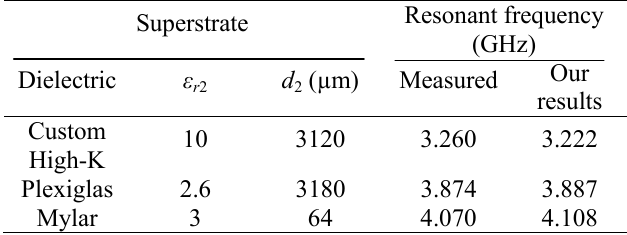
Table 1: Comparison of our calculated resonant frequencies with experimental data [16] for perfectly conducting ground plane.